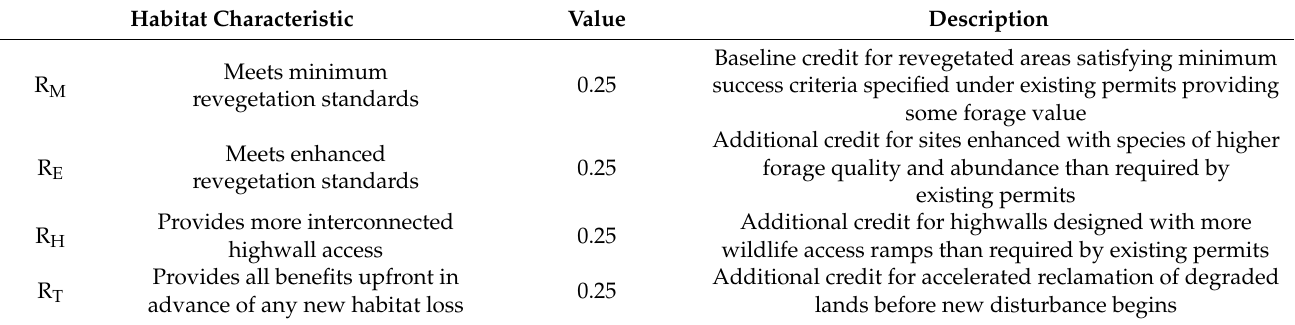
Table A2. Reclamation credits (R) assigned to habitat transformed by mining based on the extent to which reclamation activities benefit wild sheep.